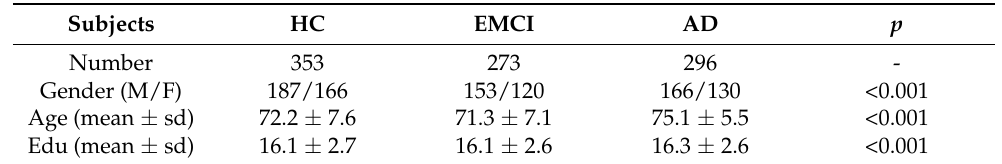
Table 1. Subject characteristics. HC = healthy control; EMCI = Early Mild Cognitive Impairment; AD = Alzheimer’s disease; M/F = male/female; Edu = education; sd = standard deviation. Subjects HC